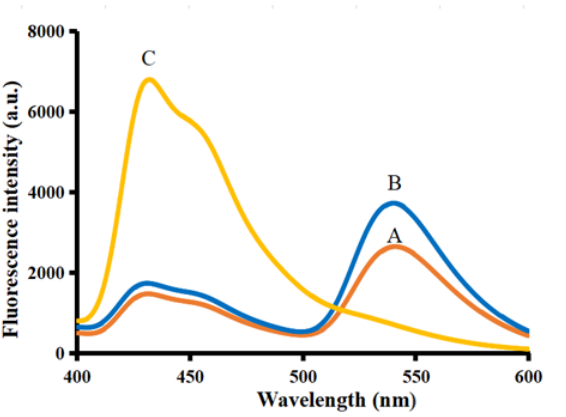
Figure 1. The feasibility of the developed method. (A) HP – DNA + DpnI + F – DNA + Exo + PFP;